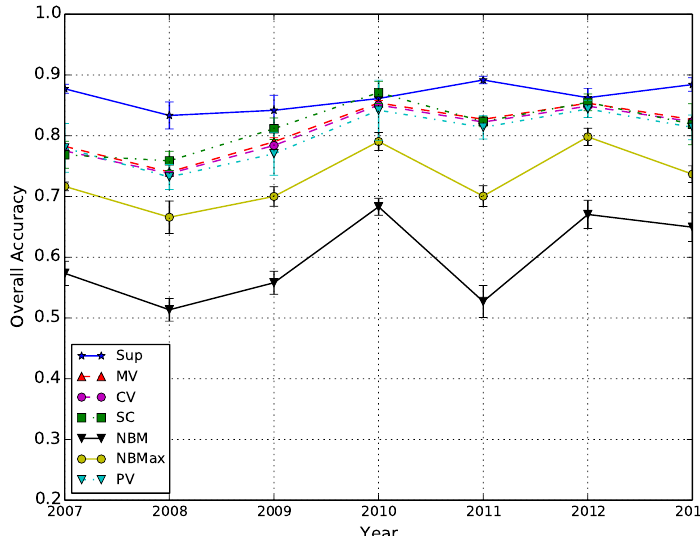
Figure 5. Overall accuracy of each method for every period. The current period is displayed on the x-axis and the OA on the y-axis. This graph represents the OA of the standard Supervised (Sup), the Majority Voting (MV), the Confidence Voting (CV), the Single Classifier (SC), the Naive Baseline Mean (NBM), the Maximum of Naive Baselines (NBMax) and the Probability Voting